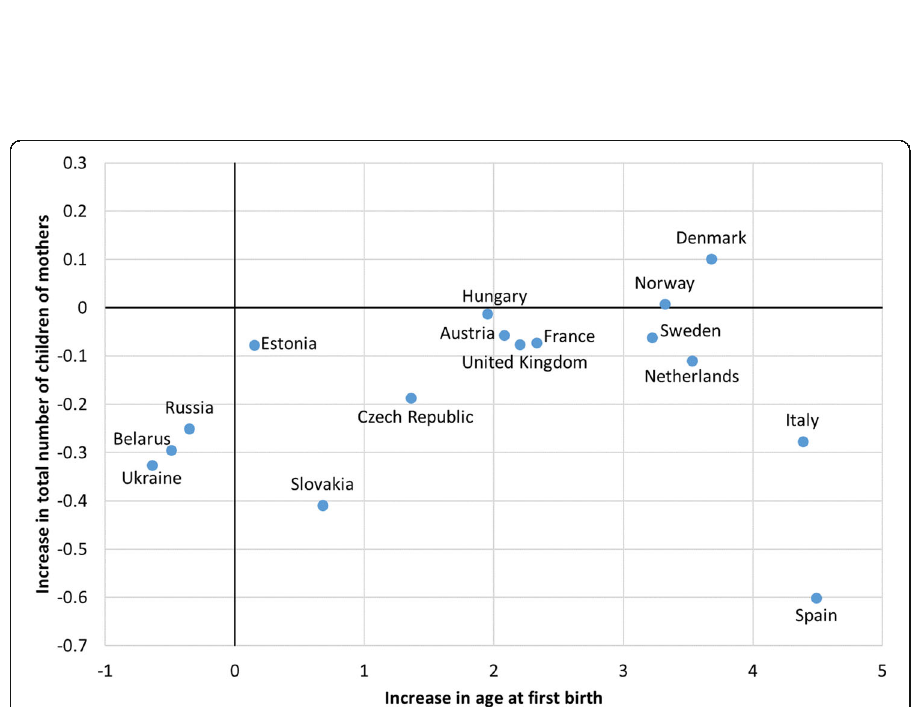
Fig. 8 Changes in the average maternal age at first birth and in the average number of children per mother born in 1952 and 1972. Source: see Figs. 5 and 6. The variation in age at first birth (in years) is shown on the x -axis and that of mothers ’ completed fertility (number of children per mother) on the y -axis. Variations are between the 1952 and 1972 birth